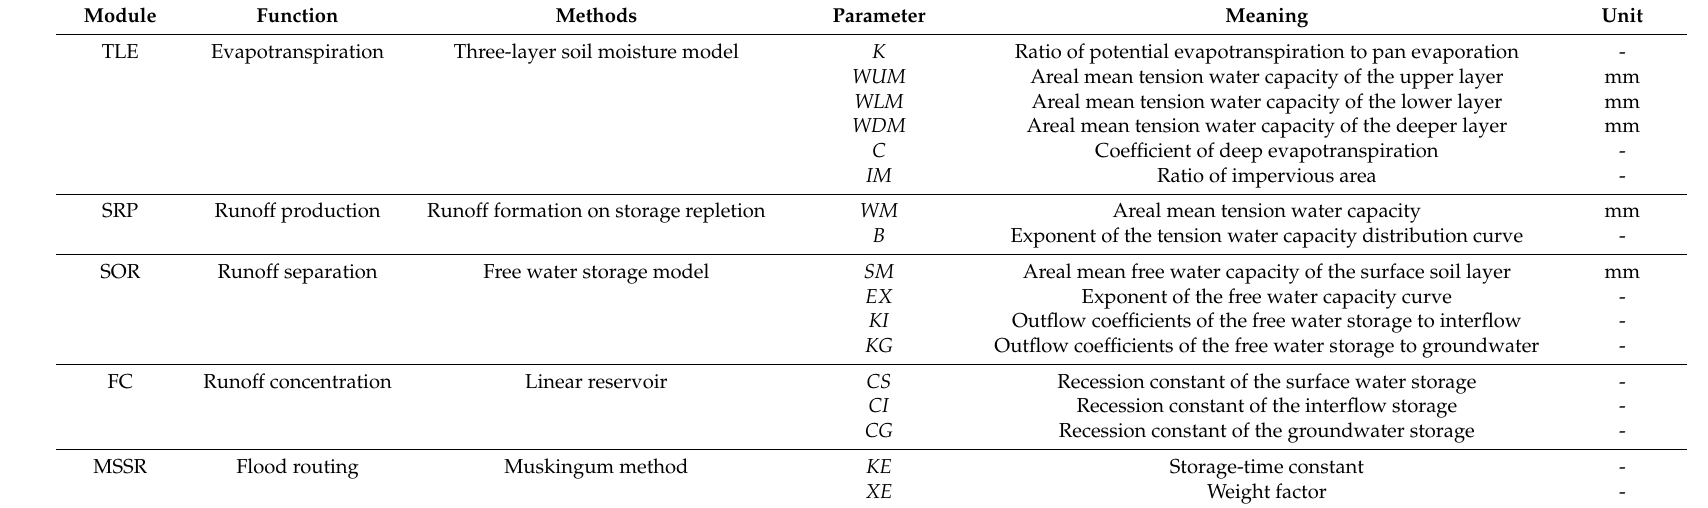
Table 1. Parameters of the XAJ model.